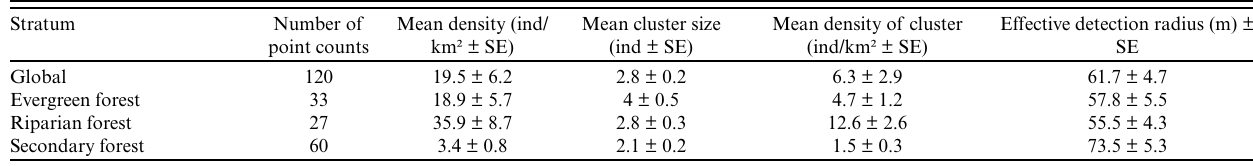
Table 1 . Multiple-covariates Distance Sampling model parameters for density estimates to 84% confidence intervals of Northern Mealy Amazons ( Amazona guatemalae ) during the breeding season (March 2014) in Los Chimalapas, Mexico. Stratum Number of Mean density (ind/ Mean cluster size Mean density of cluster Effective detection radius (m) ± point counts km² ± SE) (ind ± SE) (ind/km² ± SE) SE Global 120 19.5 ± 6.2